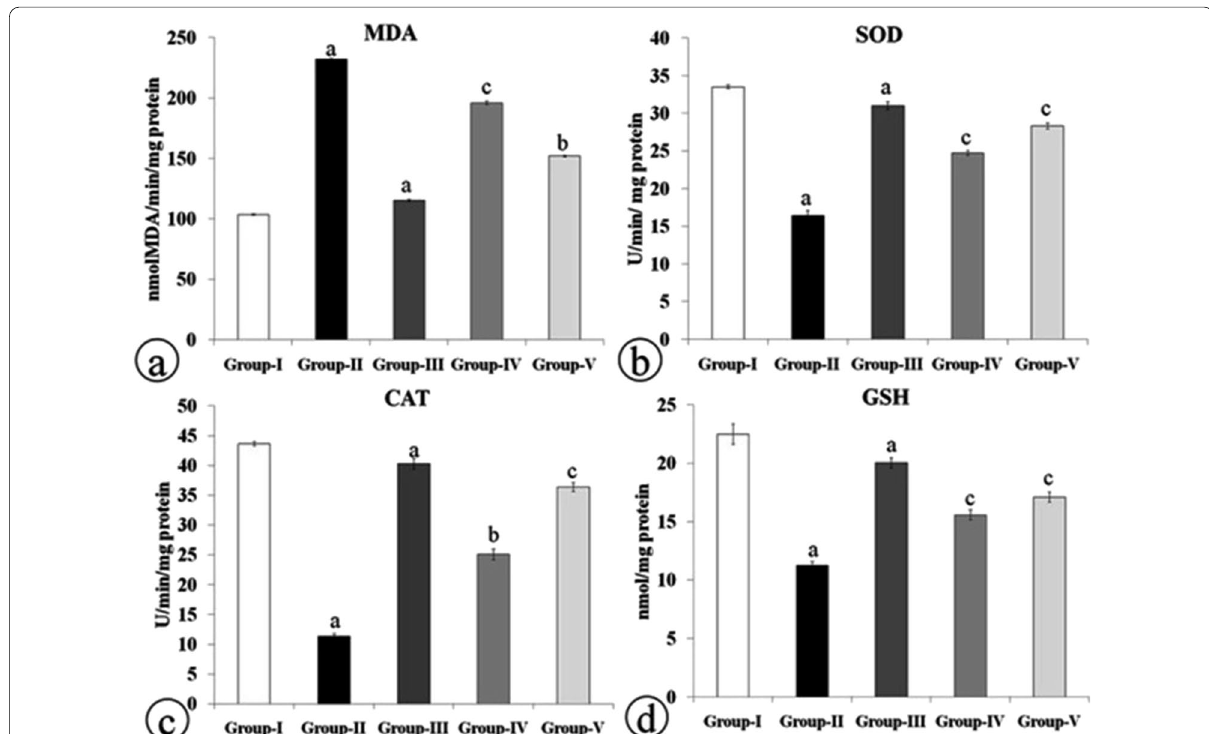
Fig. 3 Effects of ethanolic extract of L. rugosa on antioxidant enzymes activity and liver malonaldehyde content of paracetamol toxicity rats. Values are expressed as mean SEM, n 6 and were estimated using one-way ANOVA followed by post hoc Tukey HSD test. Comparisons are made ± = between (1) Group-I versus Group-II, (2) Group-II versus Group-III, IV and V. c p ˂ 0.05, b p ˂ 0.01, a p ˂ 0.001 considered as